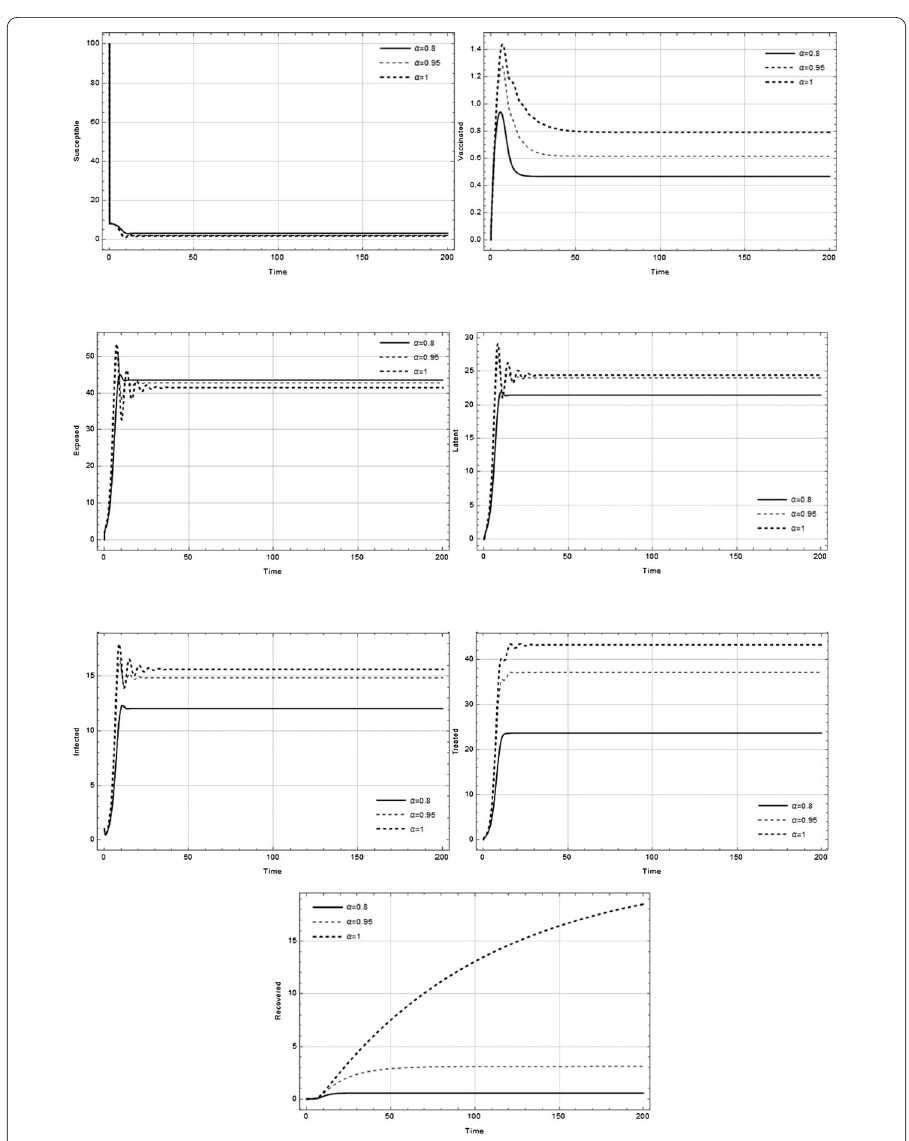
Figure 3 Endemic equilibrium state of SVELITR at different values of α for R 0 > 1 and τ = 0.035 < τ